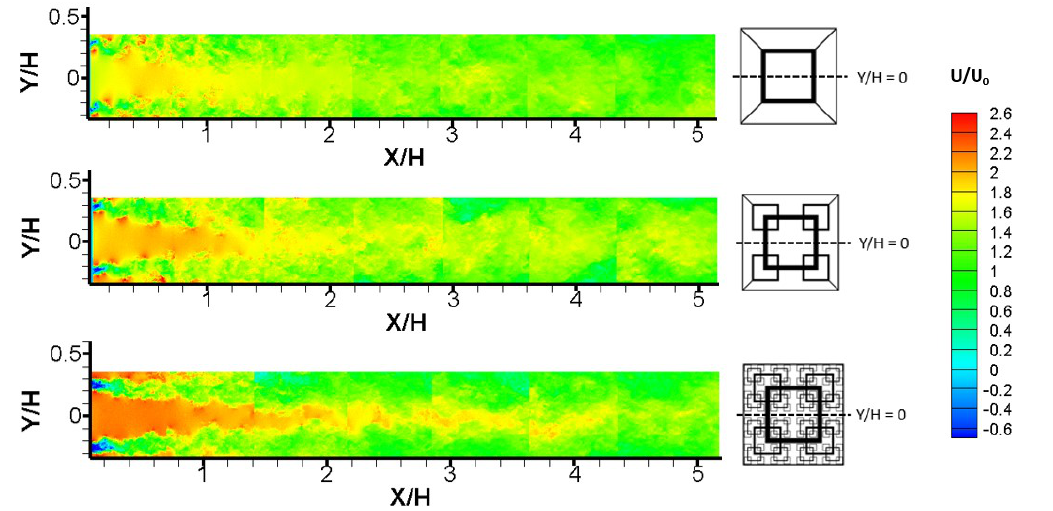
Figure 3. Instantaneous streamwise velocity U / U 0 downstream of a fractal square grid at Re = 3400. FG1, FG2 and FG4 from top to bottom.